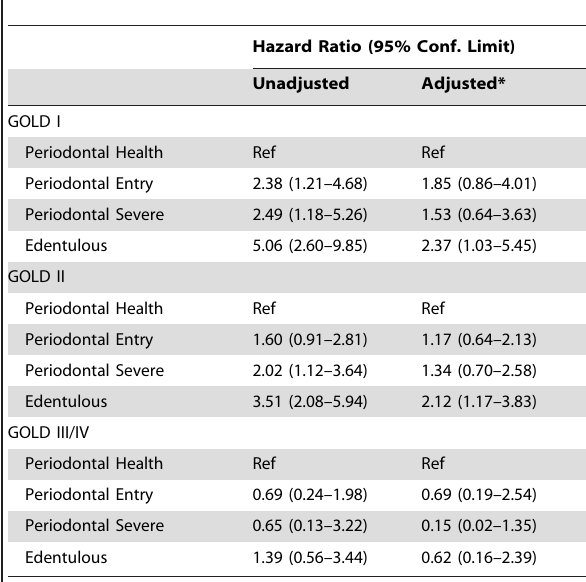
Table 5. Hazard Ratios for COPD Related Events Stratified by GOLD